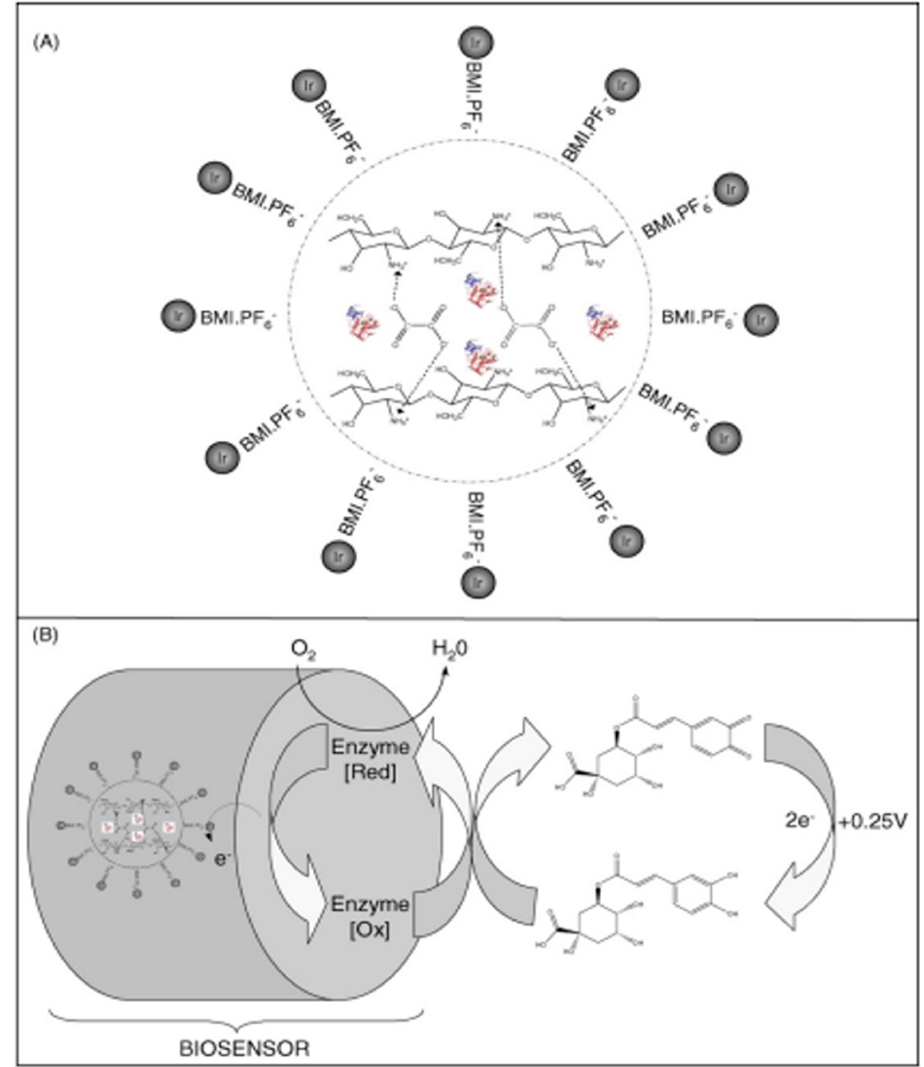
Figure 13. Schematic representation of ( A ) immobilization of PPO on chitosan crosslinked with oxalate and ( B ) reaction involving chlorogenic acid on the surface of the biosensor. Published from [76] with the permission of the